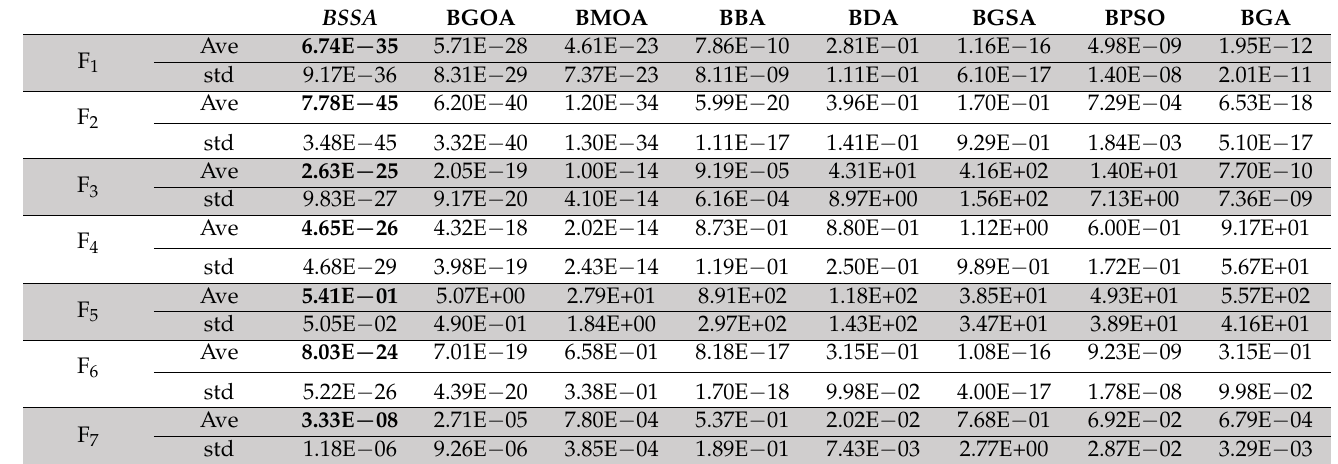
Table 5. Results for the BSSA and other algorithms in unimodal test functions.